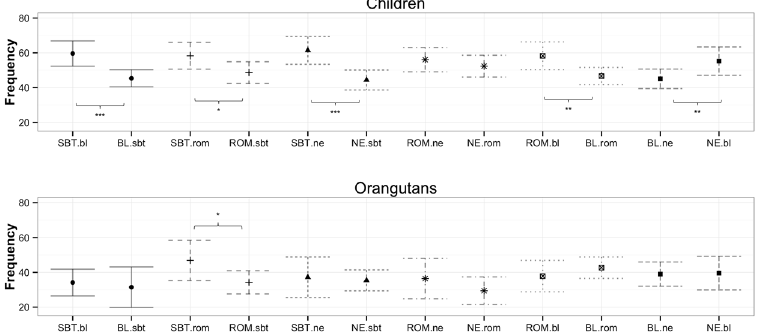
Figure 6. Fixation rates at specific pairs of orangutan facial expressions. Mean estimates for the fixation rate for each target emotion (in capital letters, e.g. “SBT”) compared to a specific distractor emotion (lower case letters, e.g., “ne”) for human children and orangutans. The corresponding combinations (e.g., SBT.ne and NE.sbt) are depicted by the same symbols and lines. SBT: silent bared-teeth display; ROM: relaxed open mouth display; BL: bulging-lip display, NE: neutral. Significant comparisons are indicated by asterisks ( > 0.01 * ; > 0.05 ** ; > 0.01 ***